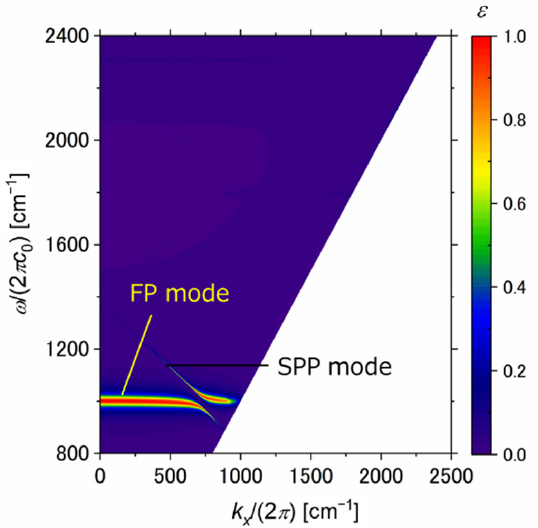
Figure 5. Emissivity contours in terms of the wavevector and x -component of wavevector for the graphene ribbon metasurface. The horizontal mode is the FP mode, and the tilted mode is the SPP mode.